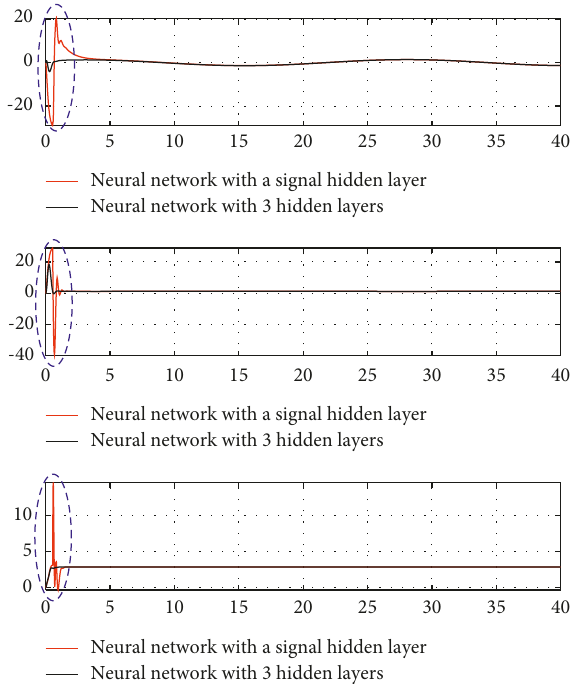
Figure 8: The attitude angle with different hidden layers neural network.